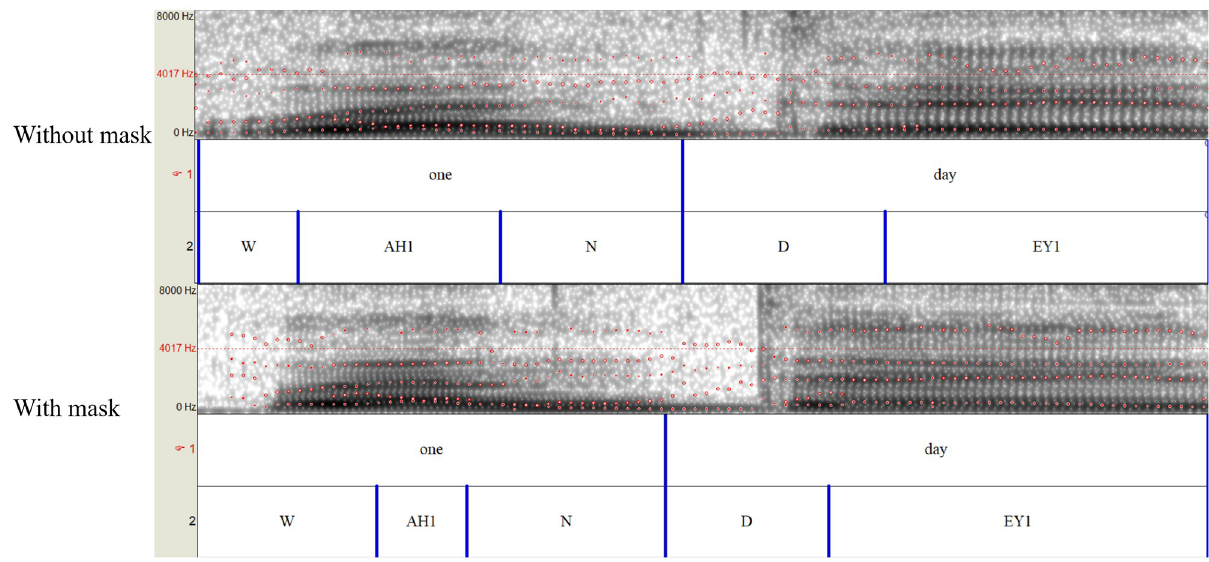
Fig 8. An example of spectrogram on the same segment (“one day” in English) of no mask speech (above) and mask speech (below). The speech was annotated in two layers, viz., word (i.e., first layer) and phoneme (i.e., second layer; in a ARPABET phone set). The red dots indicate the first four formants of